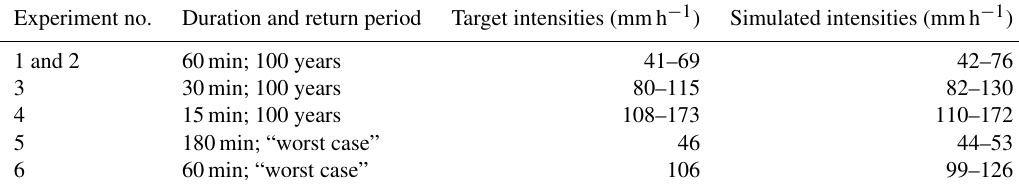
Table 2. Experiment characteristics, target and simulated intensities for all experimental sites. Experiment no.